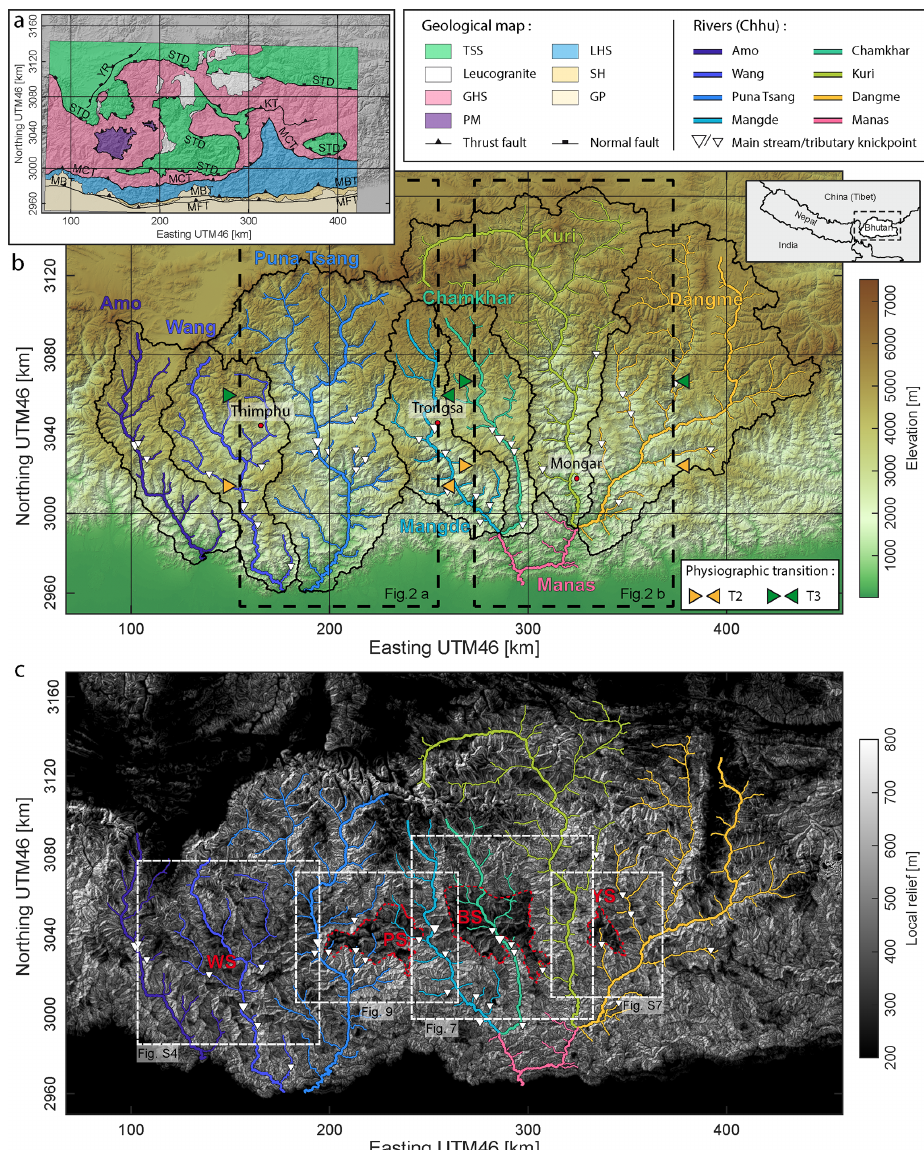
Figure 1. Topography, relief and geology of Bhutan. (a) Geological map of Bhutan, after Greenwood et al. (2016). Main tectono-stratigraphic units are from south to north: the Gangetic Plain (GP), the Siwaliks Hills (SH), the Lesser Himalayan Sequence (LHS) including the Paro metasediments (PM) in western Bhutan, the Greater Himalayan Sequence (GHS) including some leucogranites, and the Tethyan Sedimentary Series (TSS). These units are separated by major tectonic contacts, which are from north to south: the Main Frontal Thrust (MFT), the Main Boundary Thrust (MBT), the Main Central Thrust (MCT), and the South Tibetan Detachment (STD). Locally, some other contacts have been described such as the Kakhtang Thrust (KT) in north-eastern Bhutan. To the north-west of Bhutan, north of the High Himalayan range, the Yadong Rift (YR) is part of the southern Tibetan grabens. The extension of the geological map is reported over the shaded topographic map of (b) . (b) Topographic map of Bhutan, from ALOS World 3D – 30m (AW3D30) DEM data. Main drainage basins are delineated by black lines, and associated main rivers are color-coded and labeled. Thick colored lines correspond to the main trunk rivers, while thinner lines indicate main tributaries. Major knickpoints are also reported along trunk and tributary rivers. Dashed rectangles locate the swath profiles of Fig. 2a and b. Orange and green arrows on the side of these rectangles locate physiographic transitions T2 and T3 as placed in Fig. 2a and b. Inset denotes the location of the topographic map with respect to regional political borders. (c) Map of local relief, as calculated from the topography shown in (b) , with a moving window of 500m. Major high-altitude low-relief areas are manually delineated by dashed red lines. These are from west to east: the Phobjikha (PS), the Bumthang (BS), and the Yarab (YS) surfaces. In western Bhutan, another region of lower relief is also found in the Bhutan hinterland along the Wang Chhu and Amo Chhu, even though less well defined than the others: the Wang surface (WS). From west to east, dashed rectangles locate the extension of Figs. S4, 9, 7 and S7 (Figs. S4 and S7 in the